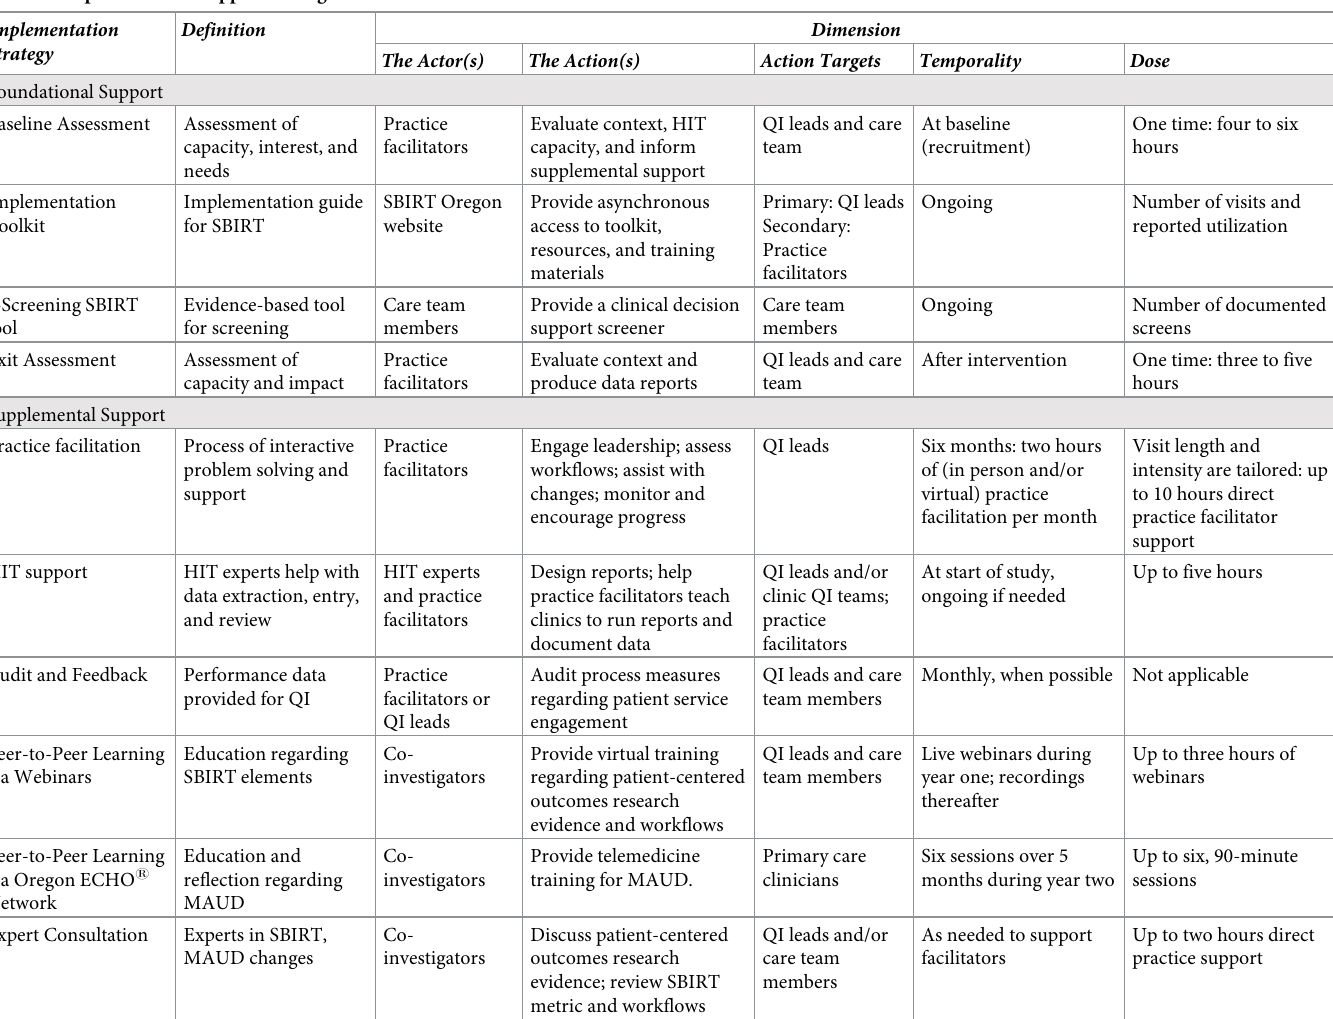
Table 3. Implementation support